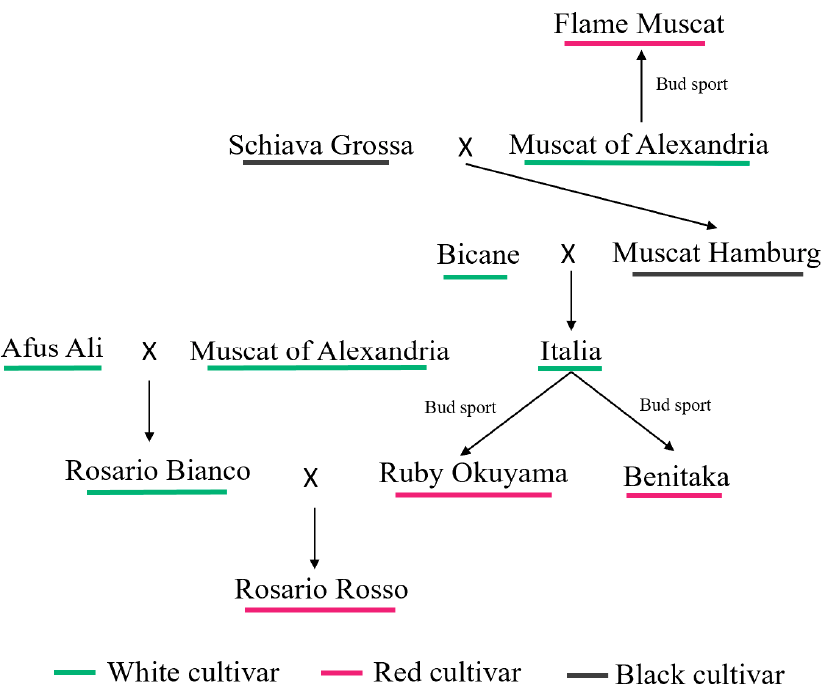
Figure 1. ‘Italia’ is associated with several grape bud sports and related relationship maps.